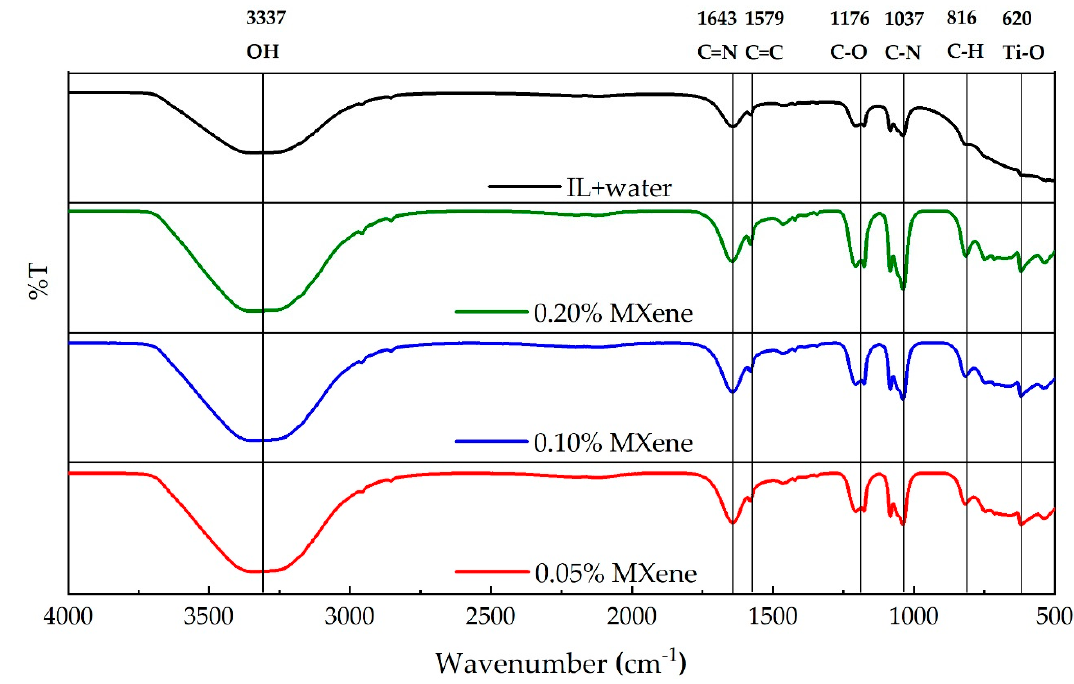
Figure 7. FTIR spectra of nanofluids at different concentrations.